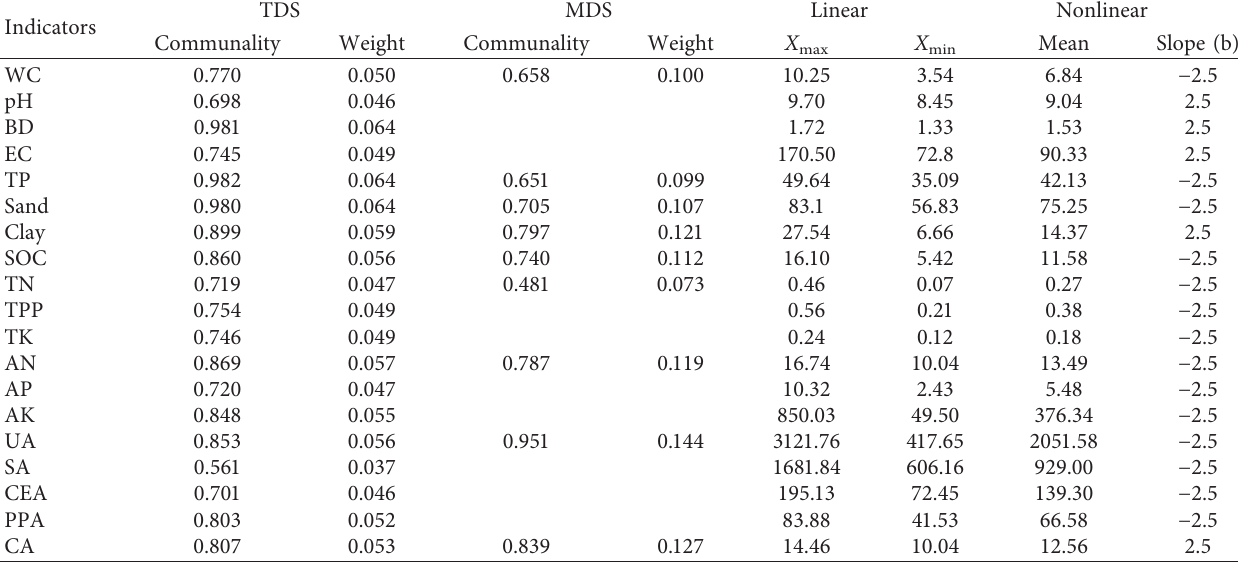
Table 6: Commonality and weight of the TDS and MDS: parameters of linear and nonlinear equations. Indicators